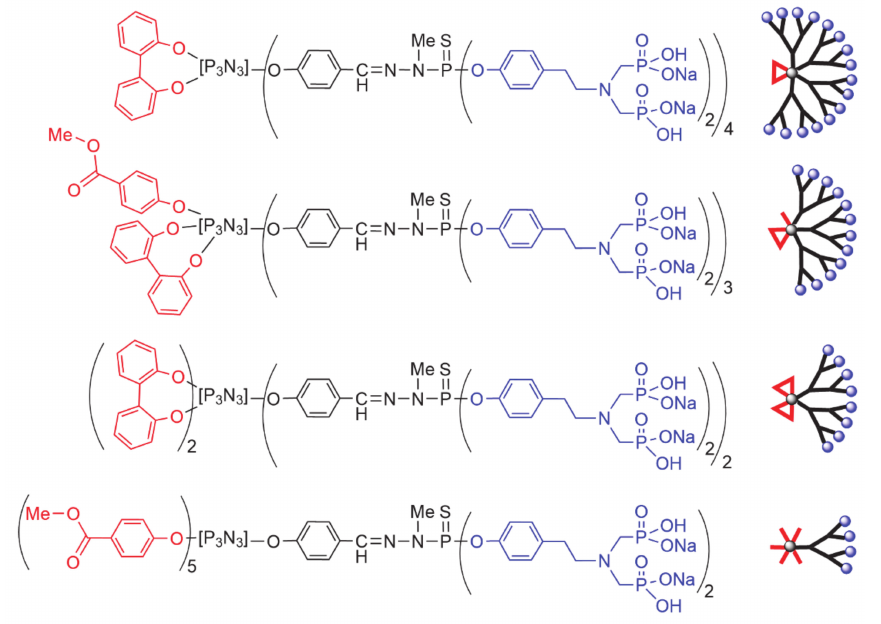
Figure 11. Chemical structure and schematization of dendritic structures having a decreased number of azabisphosphonate terminal